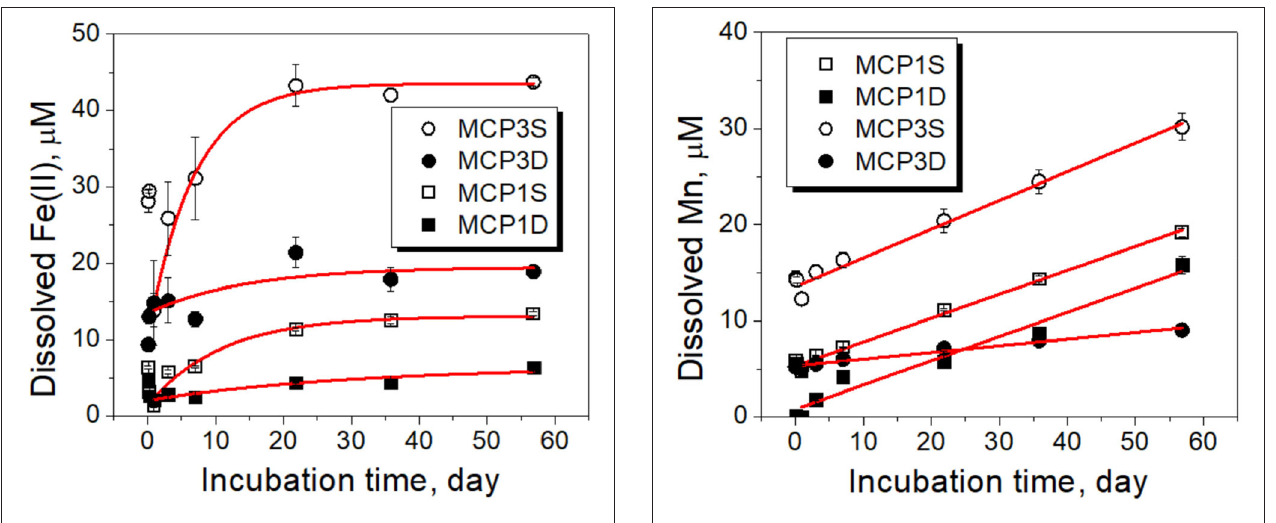
( Figure 4 ), with the amount of dissolved Fe(II) only 0.5–3% of